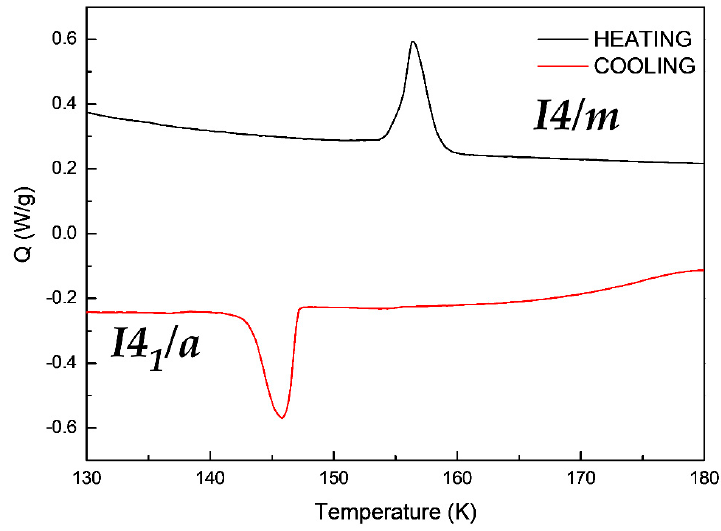
Figure 5. Differential Scanning Calorimetry measurements of compound [(CH 3 ) 3 CNH 3 ] 4 [V 4 O 12